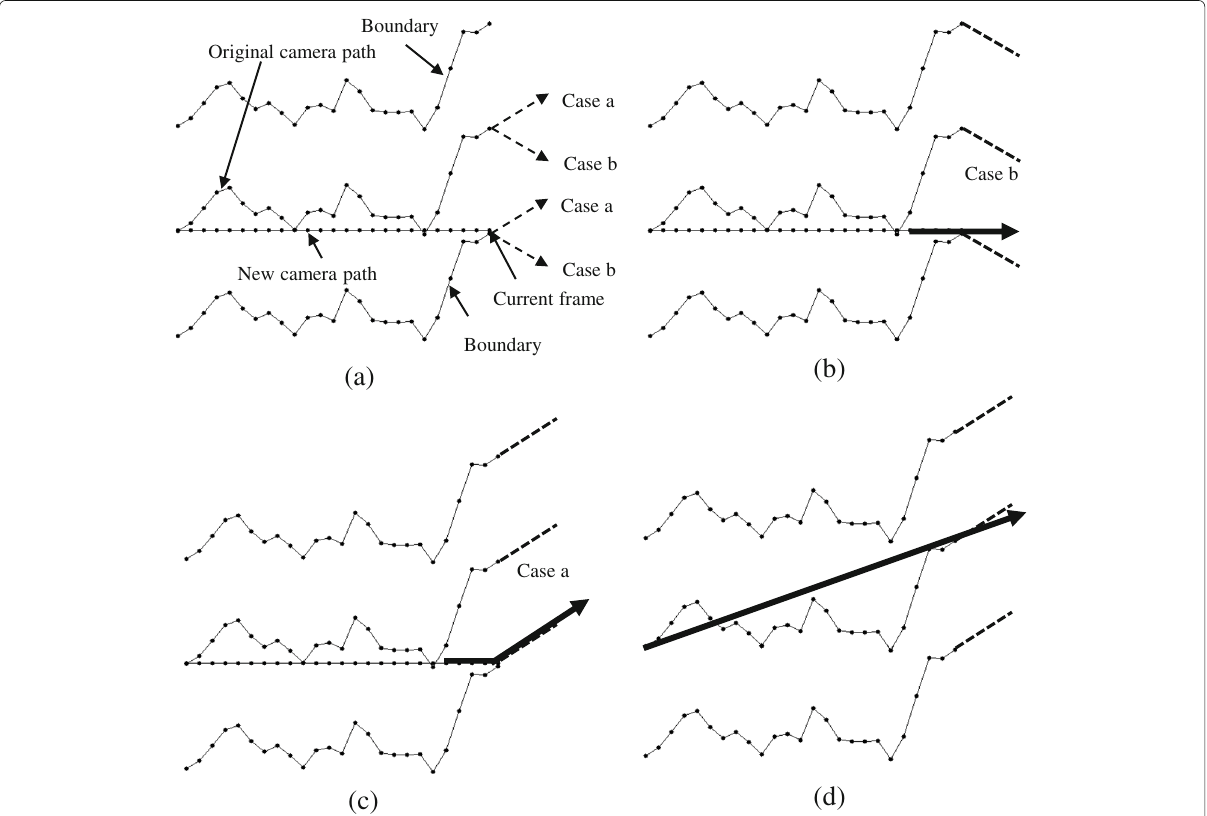
Fig. 4 Difficulty in planning a camera path for real-time video stabilization a current status, b the new camera path in “case b,” c the new camera path in “case a,” and d the ideal camera path in “case